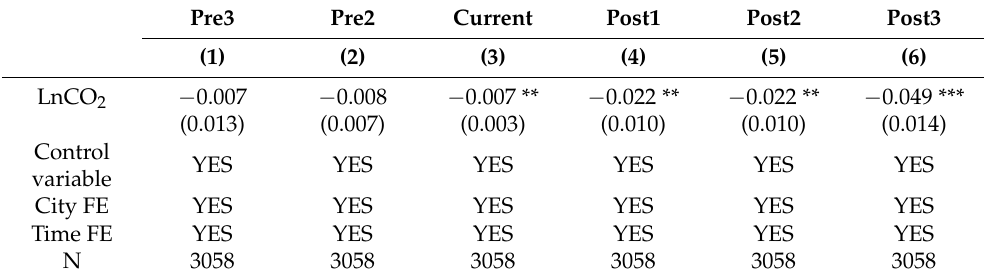
Table 4. Parallel